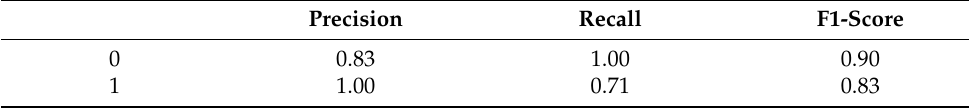
Table 6. Performance Metrics for Training Data.